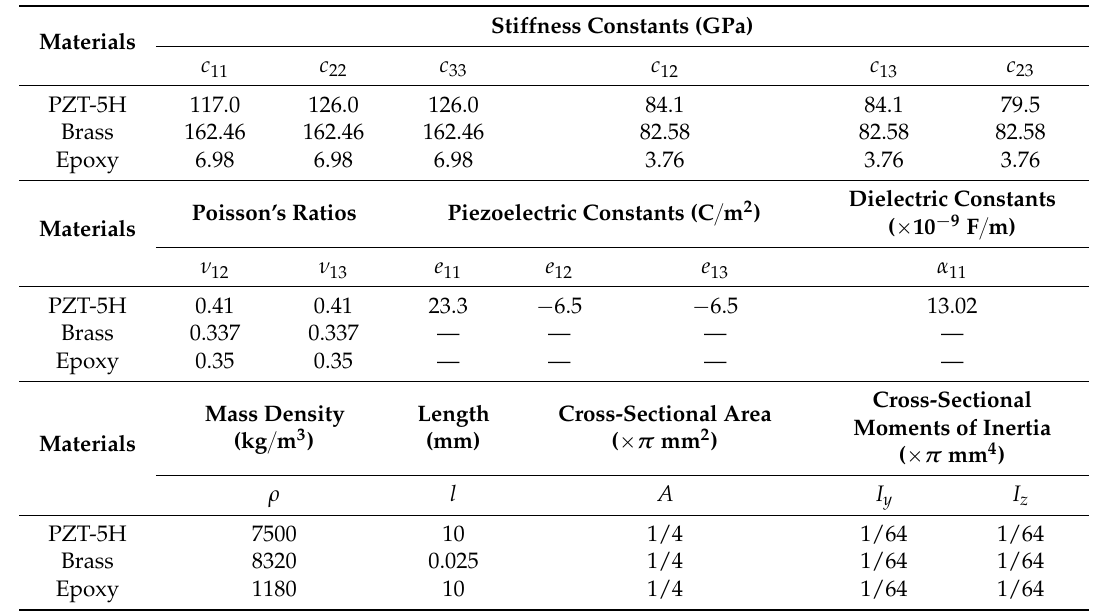
Table 2. Material and geometrical